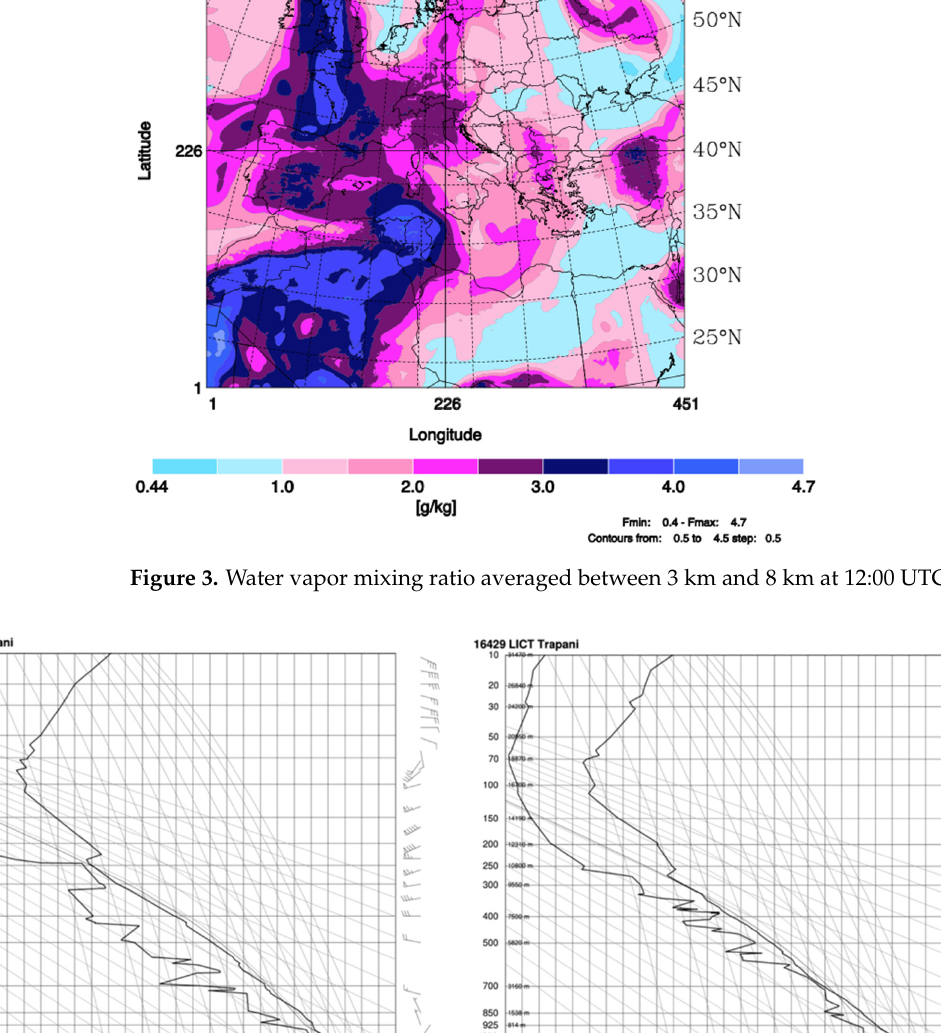
Figure 3. Water vapor mixing ratio averaged between 3 km and 8 km at 12:00 UTC on 15 July 2020.